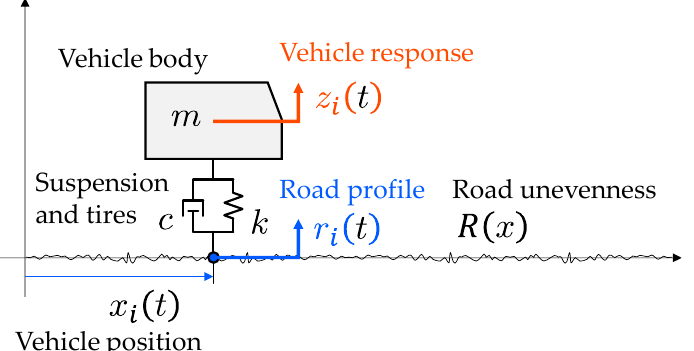
Figure 5. The vehicle system is modeled as a single degree of freedom (SDOF) system with mass, m , damping, c , and stiffness, k . The input of the vehicle system is only the road profile, r i ( t ) = R ( x i ( t )) , while the output is the vertical acceleration response, z i ( t )